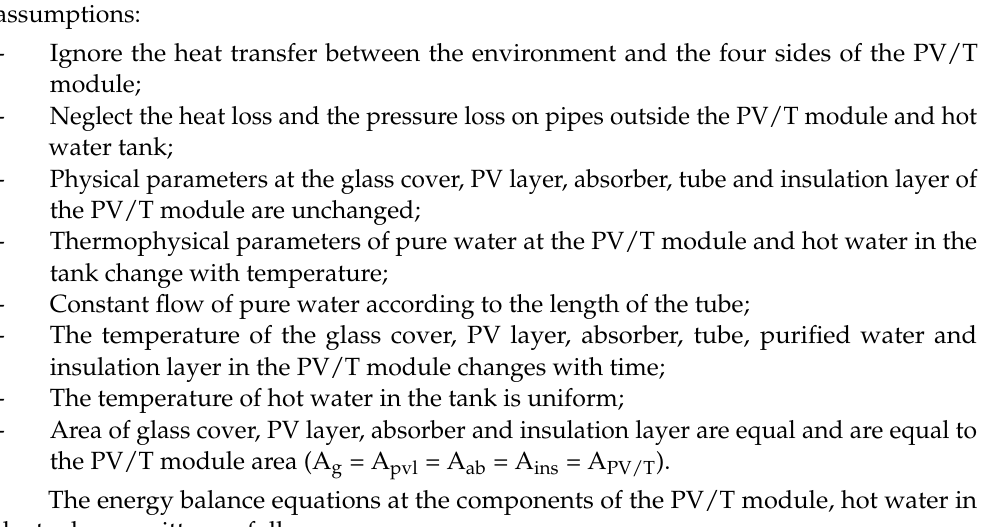
Figure 4. Structure of PV layer.